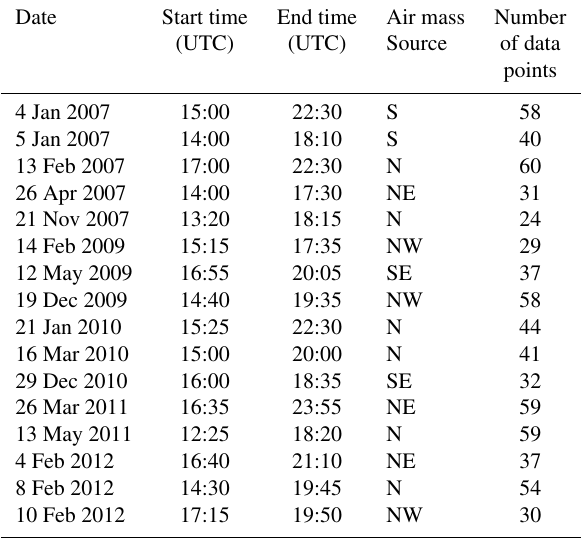
Table 1. Dates and time periods of selected low-level stratus cloud cases and their air mass source ∗